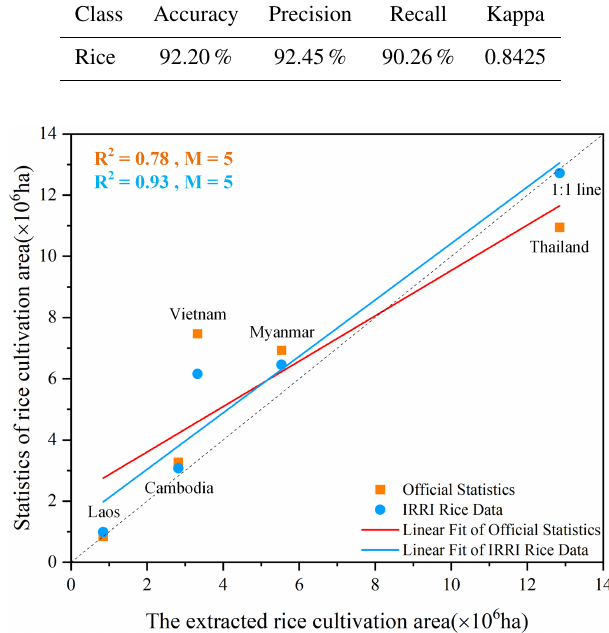
Figure 7. Comparison of the extracted rice area with the statistical rice-harvested area and IRRI data set at a national-level scale. M is the number of